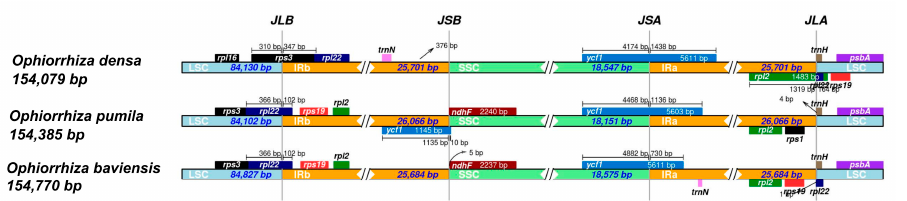
Figure 7. Comparison of LSC, IR, and SSC junction positions among the three Ophiorrhiza chloroplast genomes. JLB (junction IRb/LSC), JSB (junction IRb/SSC), JSA (junction IRa/SSC), JLA (junction IRa/LSC).